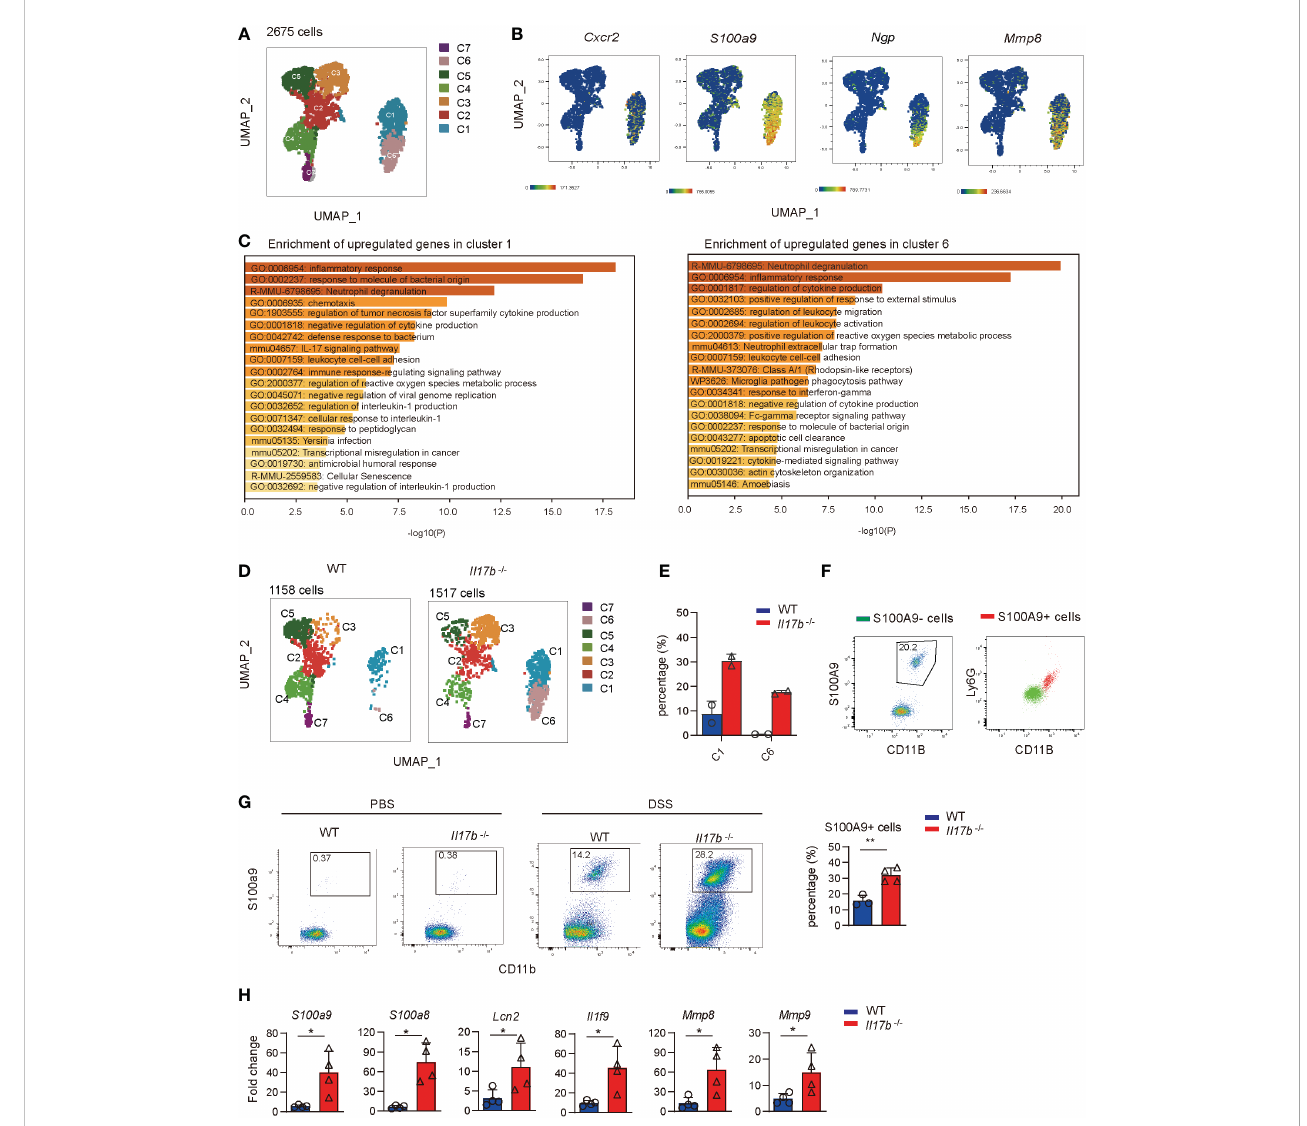
FIGURE 5 ScRNAseq analysis of myeloid cell response. (A) UMAP plot shows myeloid cell clusters. (B) The speci fi c cell markers of neutrophils were projected on UMAP. (C) Gene enrichments of upregulated DEGs in cluster 1 and cluster 6. Top 20 of terms were shown. (D) UMAPs plots showing the difference of cell clusters distribution in WT and Il17b -/- colitic mice. (E) Percentage of cell cluster 1 and 6 in WT and Il17b -/- colitic mice. (F – H) WT and Il17b -/- mice (n = 4/group) were fed with 2.5% DSS water for 6 days. (F) The in fi ltration of CD11B + S100A9 + in colon lamina propria was detected by fl ow cytometry on day 8 (right panel). The CD11B + S100A9 + cells express Ly6G, con fi rming neutrophils phenotype (left panel). (G) The percentages of CD11B + S100A9 + neutrophils in CD11B + cells were compared between WT and Il17b -/- colitis mice. Bar graph showing the statistic of the CD11B + S100A9 + cells in colitis mice. (H) The in fl ammatory genes expression in colonic lamina propria CD45 + cells was detected by real-time PCR. For bar graphs, data are expressed as mean ± SD. * P < 0.05; ** P < 0.01, determined by unpaired t test. The experiment was performed 3